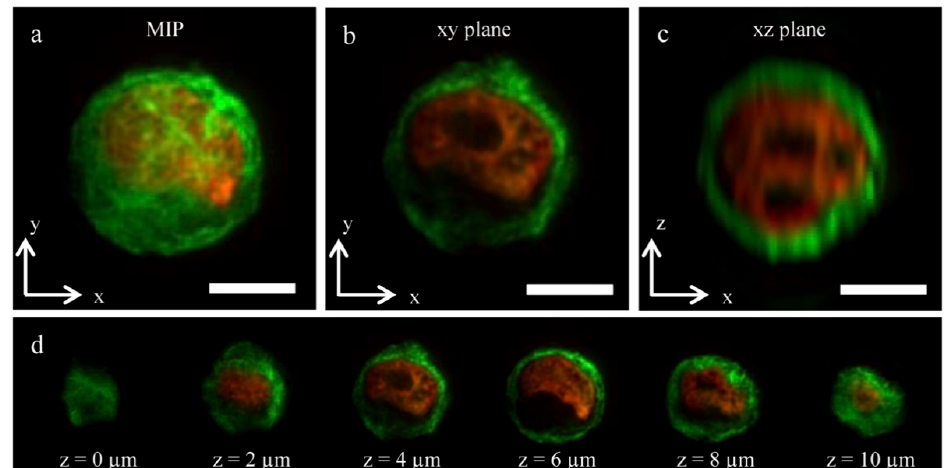
Figure 7. 3D images captured in a microfluidic channel of human mammary epithelial cells taken in each 2D plane, panels ( a – c ). Panel ( d ) represent images of the mammary epithelial cells in an XY plane with various sizes of z being used to image. Reproduced from [91] under Creative Commons Attribution 4.0 License.